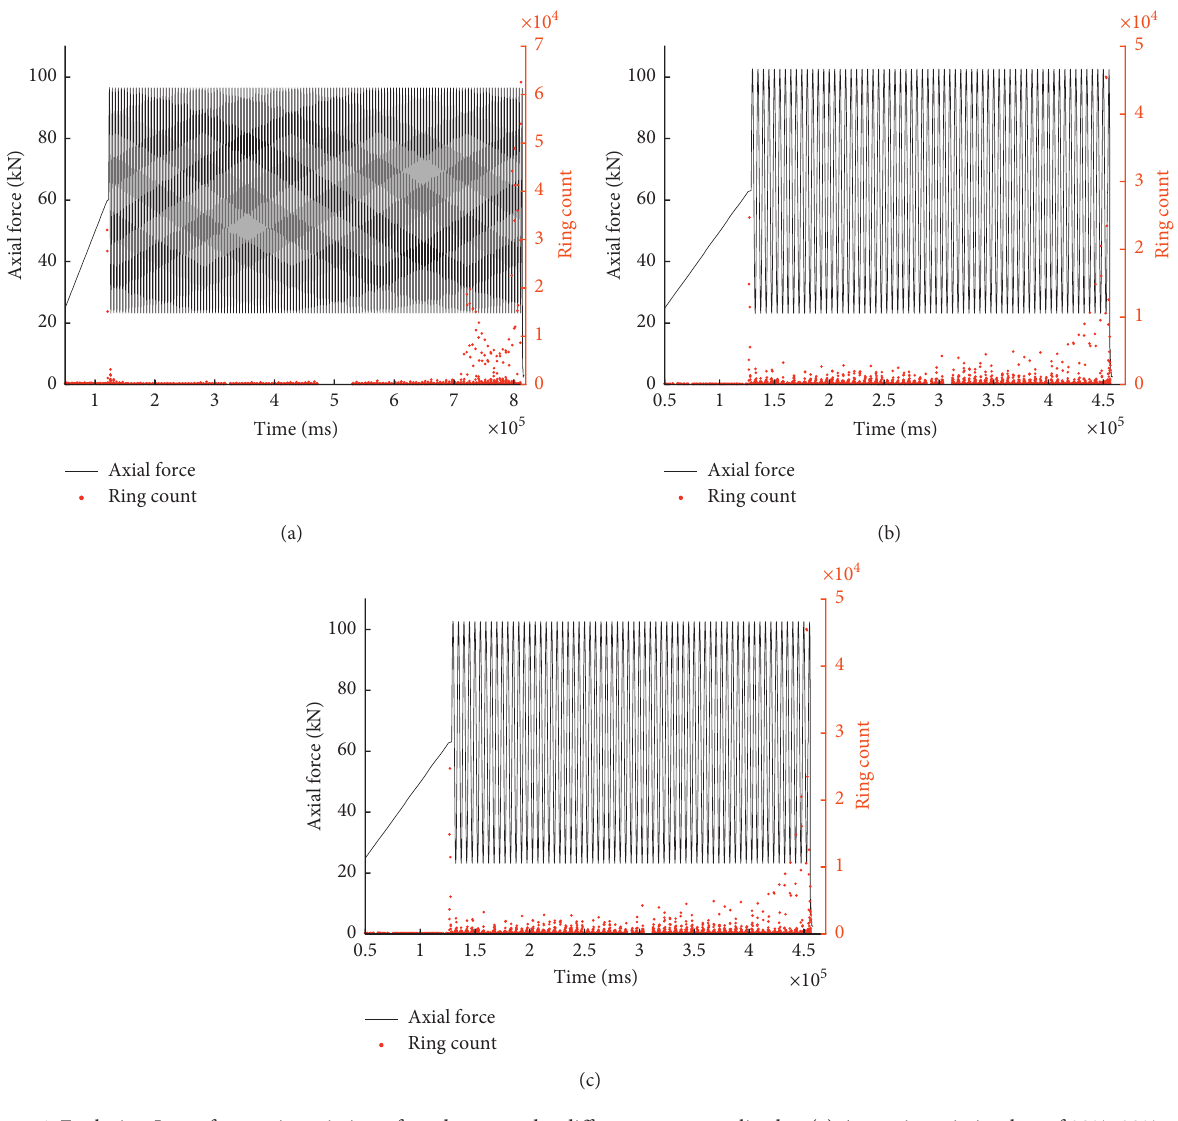
Figure 4: Evolution Law of acoustic emission of sandstone under different stress amplitudes. (a) Acoustic emission law of 20%–80% stress level. (b) Acoustic emission law of 20%–85% stress level. (c) Acoustic emission law of 20%–90% stress